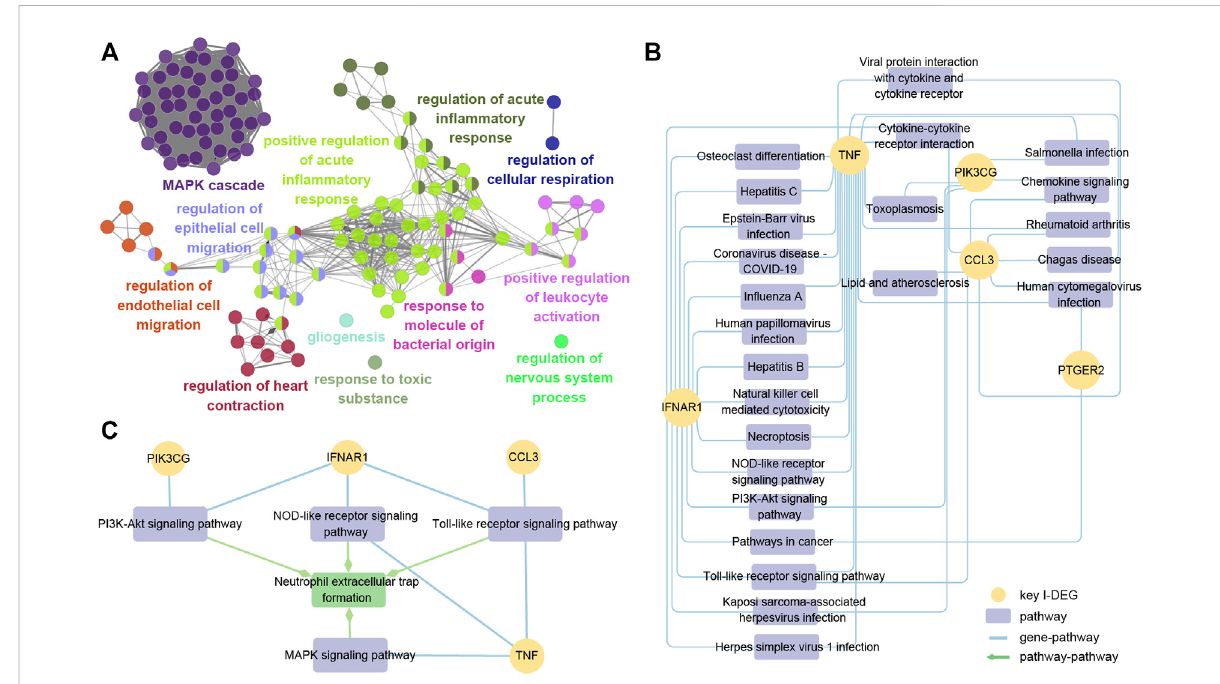
FIGURE 10 (A) ClueGO fusion and cluster result of biological processes involved in key I-DEGs; (B) Key I-DEGs-pathway networks; (C) The relationship between NETs formation pathway and key